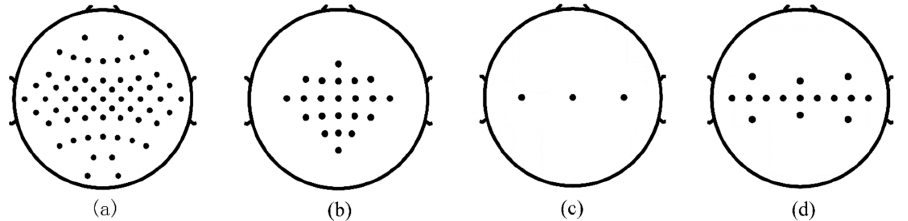
Figure 1. Distribution of electrodes on the scalp for all datasets. ( a ) dataset 1, ( b ) dataset 2, ( c ) dataset 3. ( d ) dataset 4.